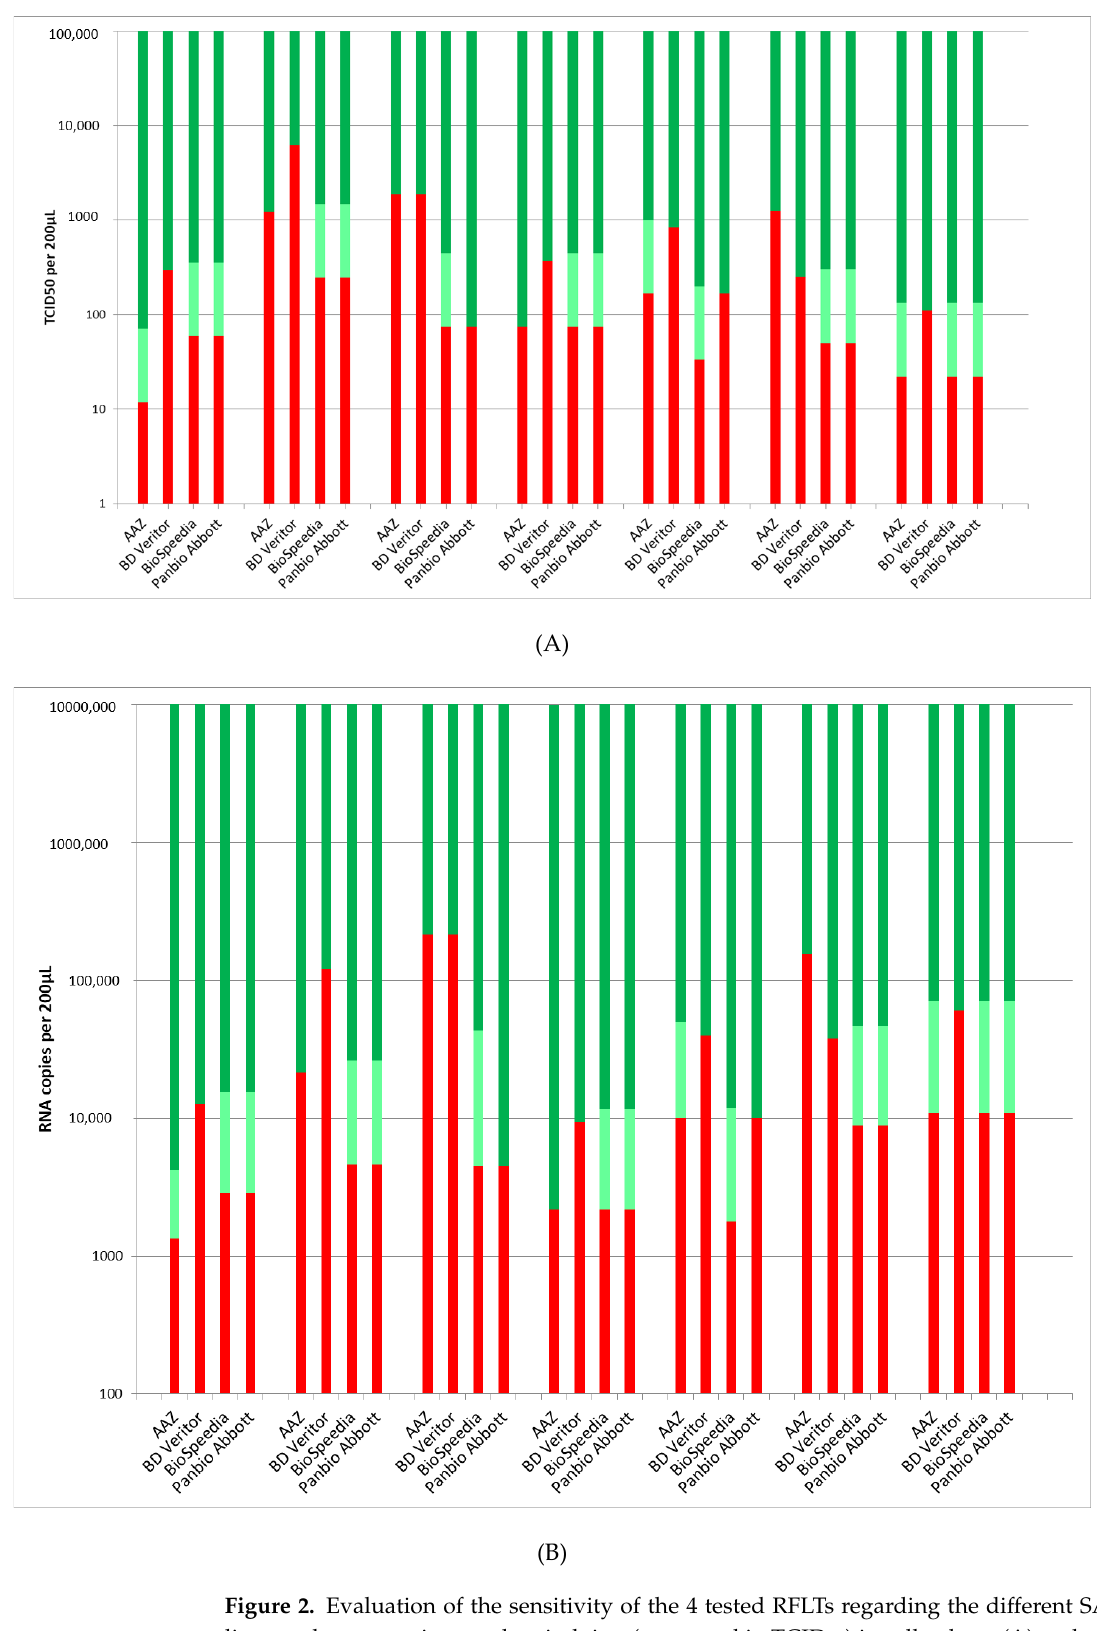
Figure 2. Evaluation of the sensitivity of the 4 tested RFLTs regarding the different SARS-CoV-2 lineages by comparison to the viral titer (expressed in TCID 50 ) in cell culture ( A ) and to viral load (expressed in RNA copies) in quantitative RT-PCR ( B ). Color symbols: dark green = positive; light green = weakly positive; red =